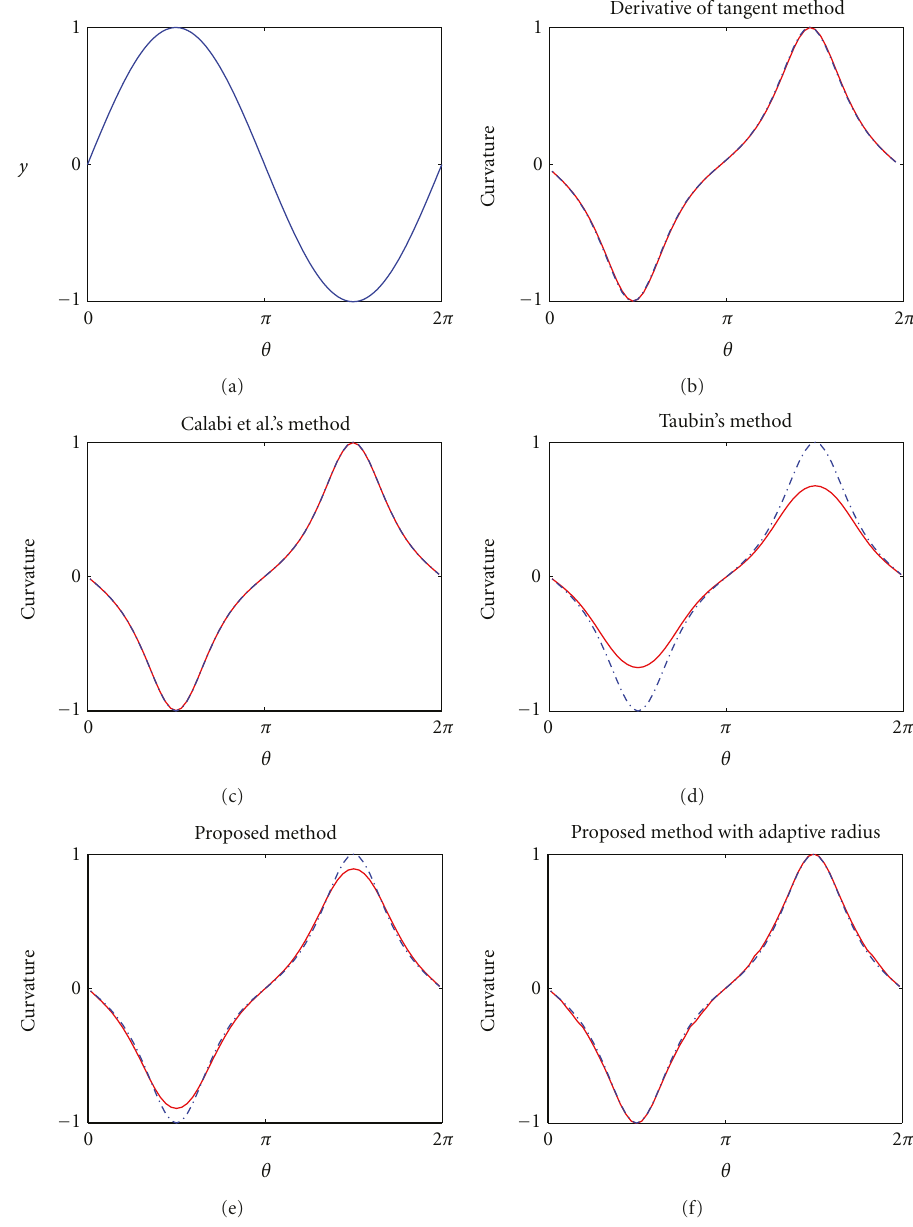
Figure 6: (a) A sinusoidal waveform, (b) curvature estimate obtained by derivative of tangent, (c) curvature estimate obtained by Calabi et al.’s algorithm, (d) curvature estimate obtained by Taubin’s algorithm, (e) curvature estimate obtained by line integrals, and (f) curvature estimate obtained by line integrals with adaptive radius. Notice that a dashed blue line denotes the true